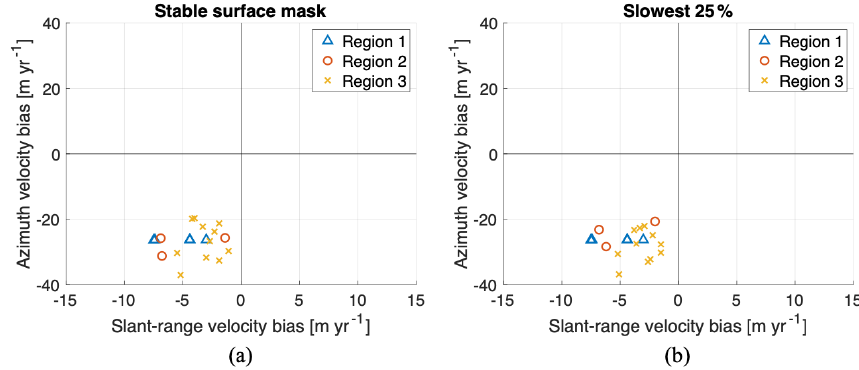
Figure 9. Full-swath geolocation bias-induced slant range and azimuth velocity bias: (a) with stable surface mask, (b) considering the slowest 25% as stable surfaces. The 20 Sentinel-1A/B image pairs in Regions 1, 2 and 3 are used. We use the pair convention of Sentinel-1A acquired prior to Sentinel-1B with 6d time